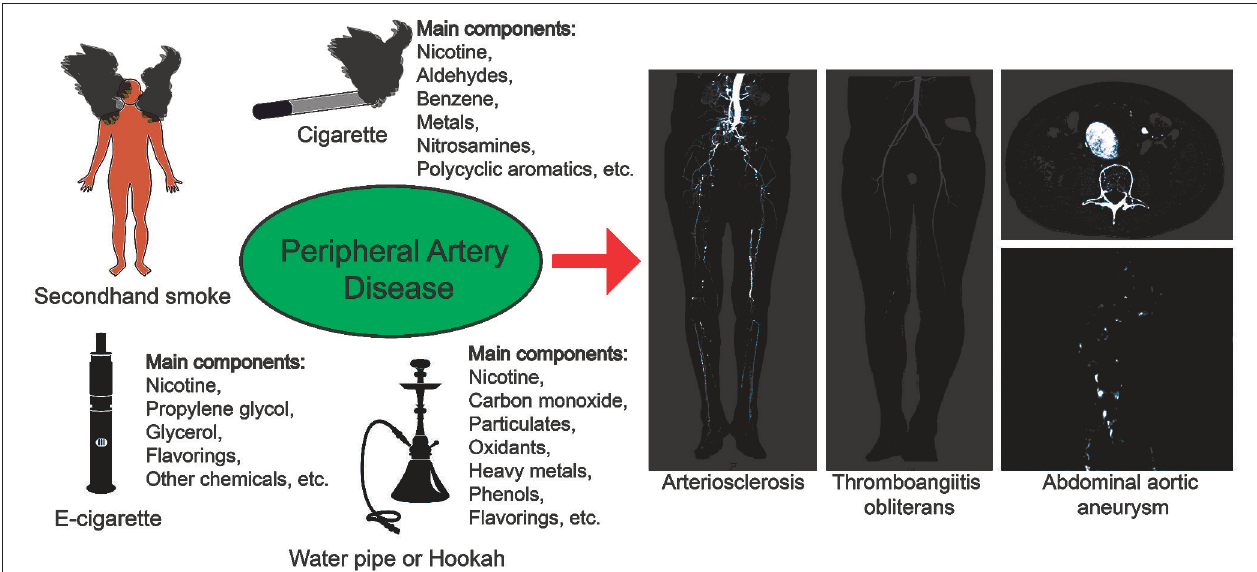
FIGURE 1 | Smoking and peripheral artery disease. Different types of smoking may cause peripheral vascular diseases, such as arteriosclerosis, thromboangiitis obliterans, and abdominal aortic aneurysm. The ingredients in different cigarettes and substitutes are different, but they may all pose a risk of cardiovascular disease.